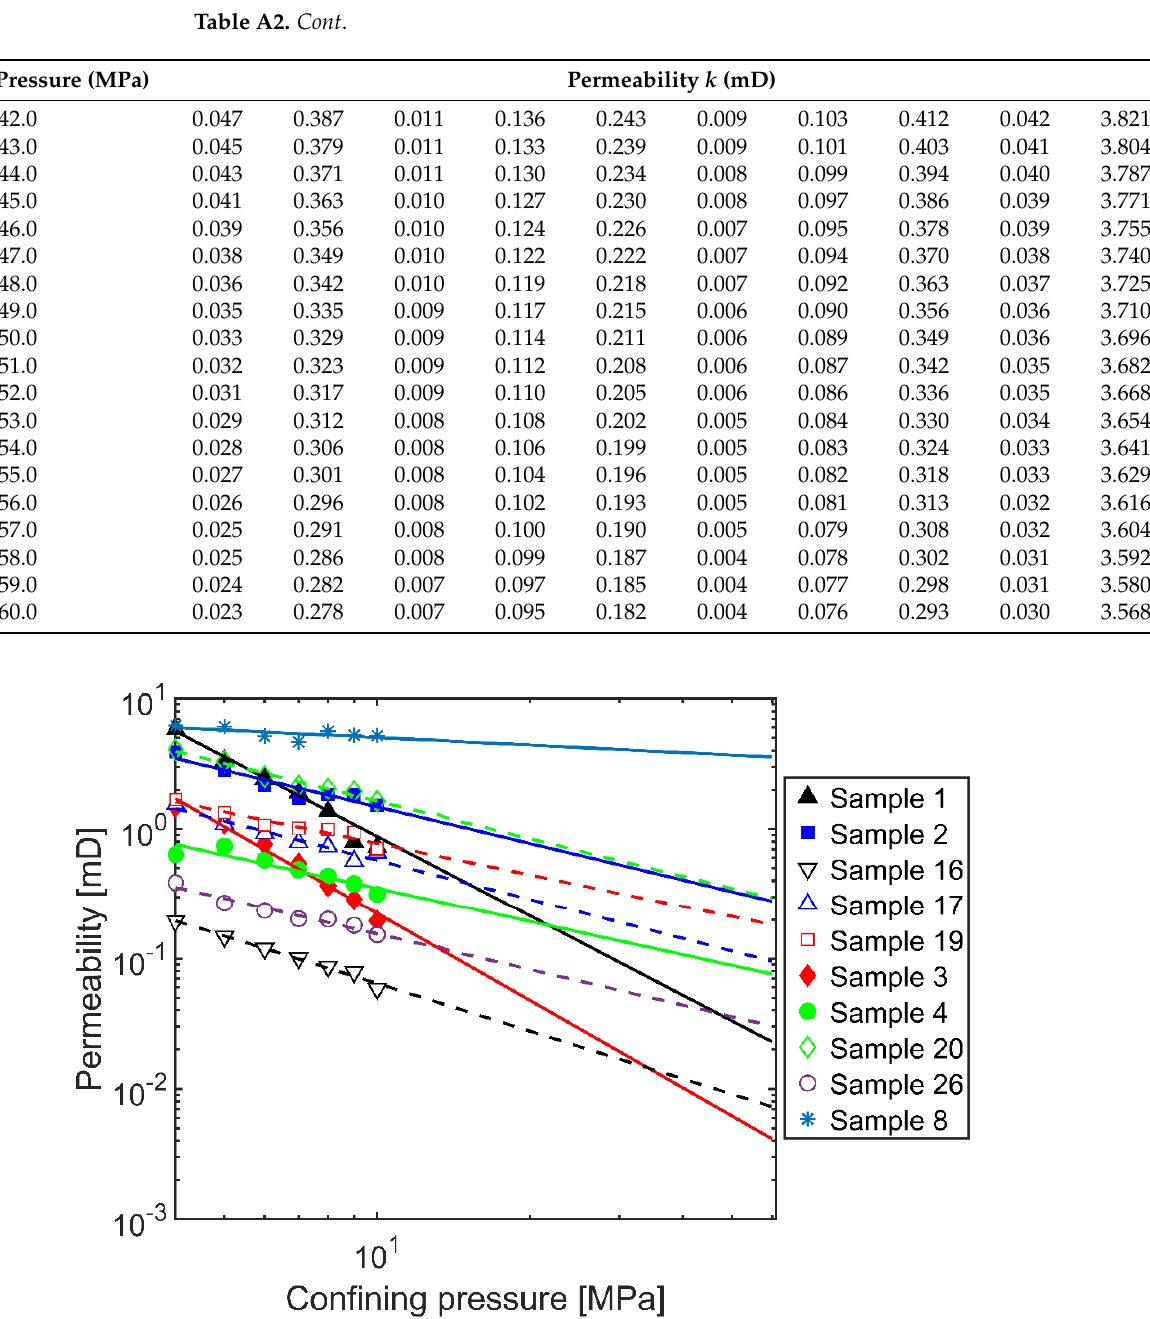
Figure A1. Power law correlations between permeability and confining pressure (as in Figure 6) on a log-log scale together with the measured permeability data for the different samples.